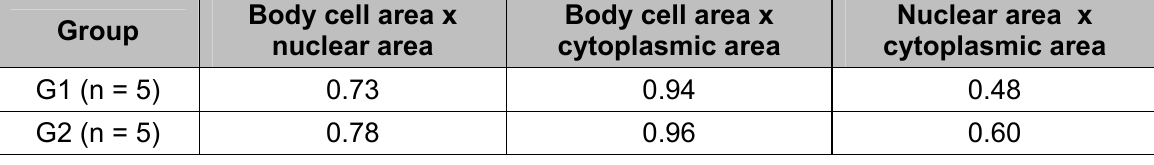
Figure 1. ( A ) Myenteric ganglion of jejunum from a healthy rat (G1) and ( B ) a rat infected with a genotype III Toxoplasma gondii strain (G2) for 24 hours. Table 3. Intergroup correlations for body cell, nuclear and cytoplasmic areas of rat jejunum neurons from healthy rats (G1) and those infected by a genotype III Toxoplasma gondii strain (G2) for 24 hours